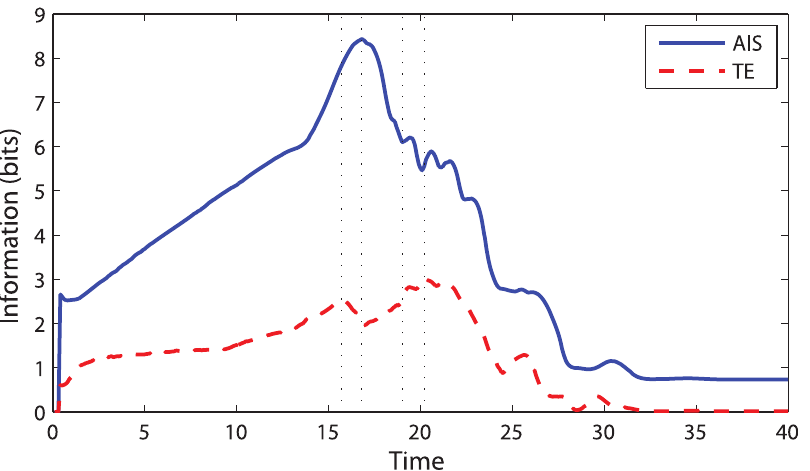
doi:10.1371/journal.pone.0040084.g001